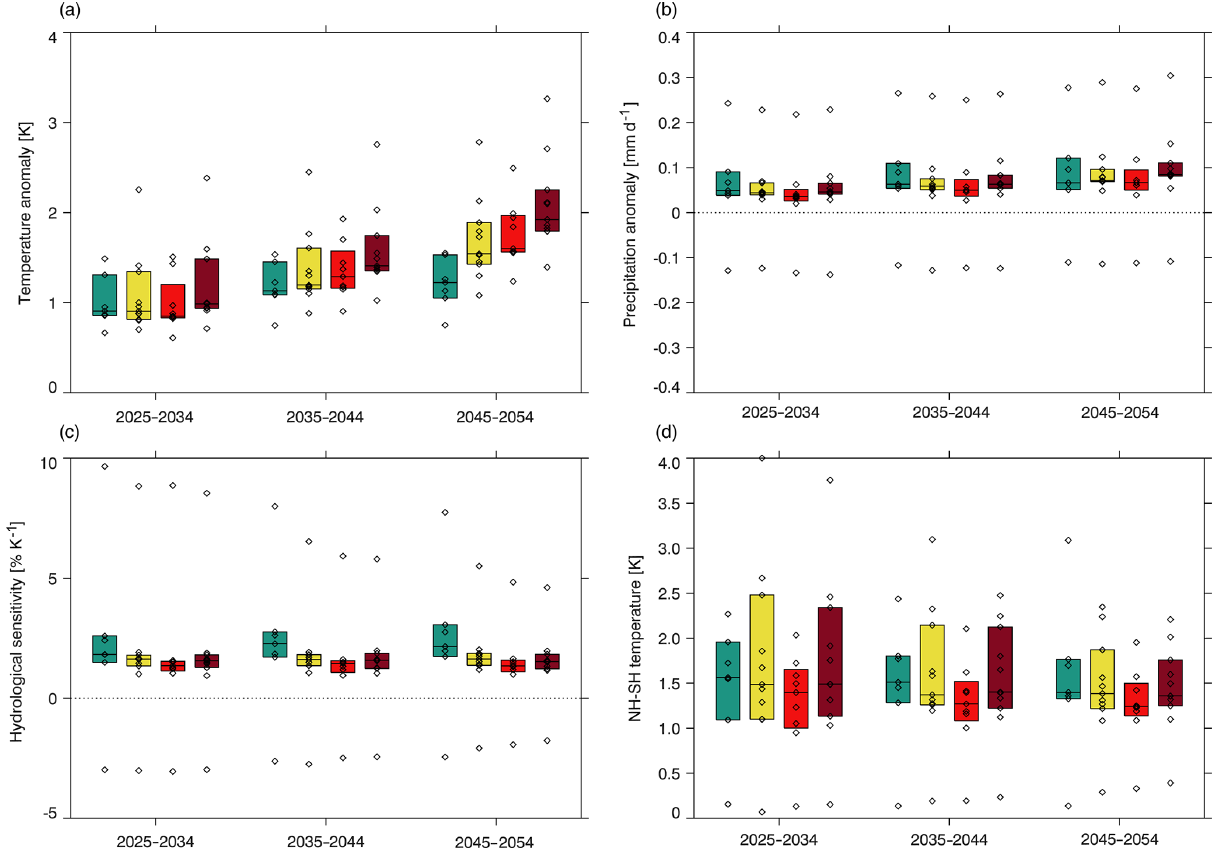
Figure 7. Global-mean annual-mean anomalies in (a) near-surface temperature (K), (b) precipitation (mmd − 1 ), and (c) hydrological sen- sitivity (%K − 1 ) relative to 1980–2014. (d) Annual-mean anomalies in interhemispheric temperature gradient (K) relative to 1980–2014. Coloured bars show the interquartile range, and the horizontal bar within this shows the median. Diamonds show values from each model listed in Table 1 as having data availability for a given SSP. Where multiple ensemble members are available, the model mean is